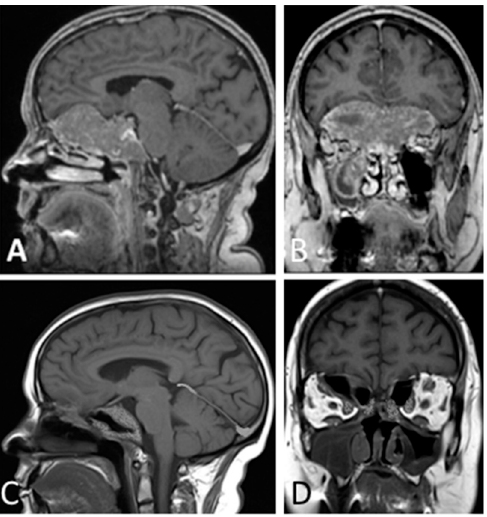
Figure 4. T1- weighted contrast-enhanced MR images. Preoperative sagittal ( A ) and coronal ( B ) views showing a giant pituitary macroadenoma, Knosp grade 3, extended to the right maxillary sinus, subfrontal, and clival areas. Three-month postoperative sagittal ( C ) and coronal ( D ) views showing STR with residual tumor left in the clival, right subfrontal, and right orbital areas.